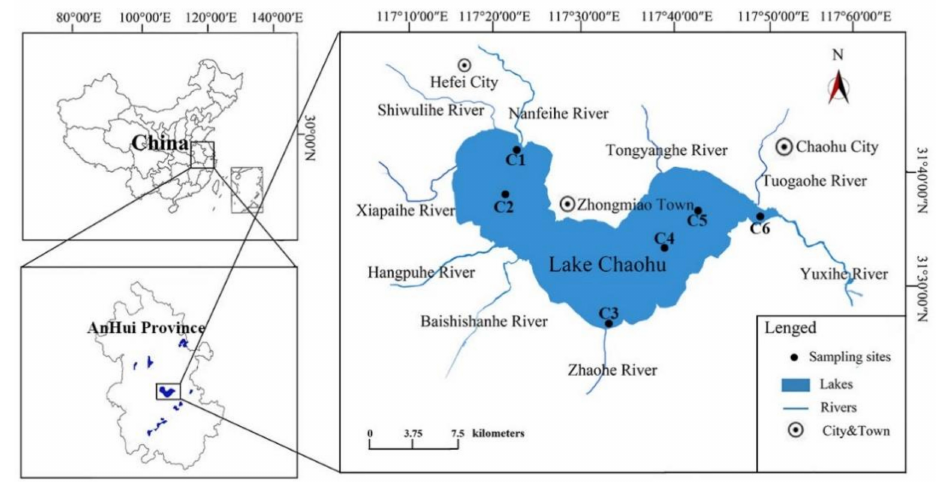
Figure 1. Location of sampling sites in the eutrophic Lake Chaohu, Anhui,